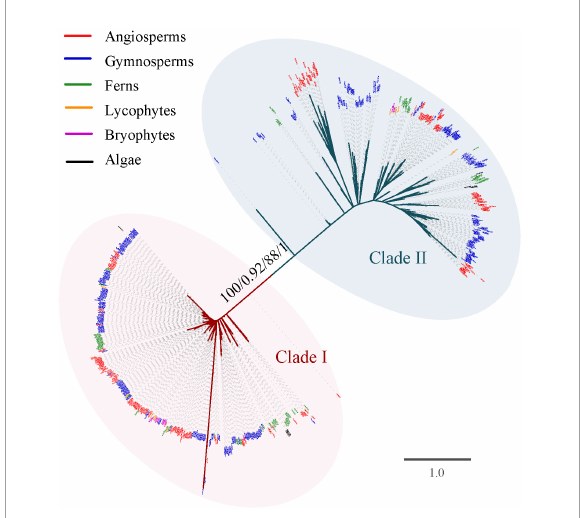
FIGURE2 Phylogenetic tree of the TCP gene family constructed based on the amino acid sequences of the TCP domain. The tree was not rooted. Branch lengths indicate the number of amino acid residues substitutions per site and are drawn to scale. Numbers associated with nodes are UFBoot support values and posterior probability in the phylogeny analysis based on amino acid sequences (first and second) and CDS (third and fourth), respectively. All species abbreviations are listed in Supplementary Table 1